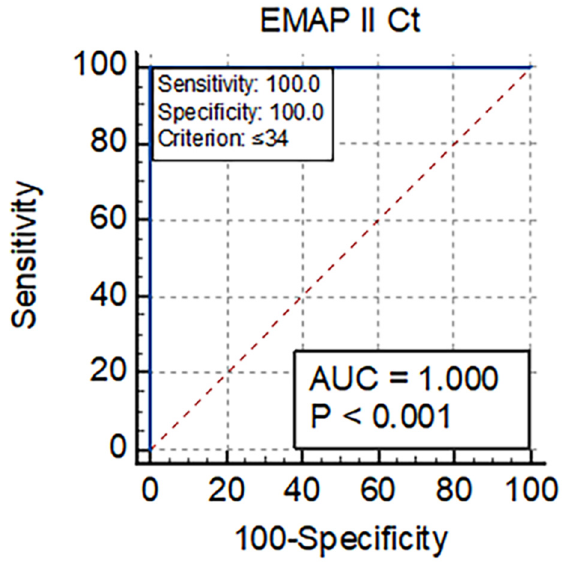
Figure 1. ROC curves of EMAP II as predictors of mortality in the severe COVID-19 patient’s group.